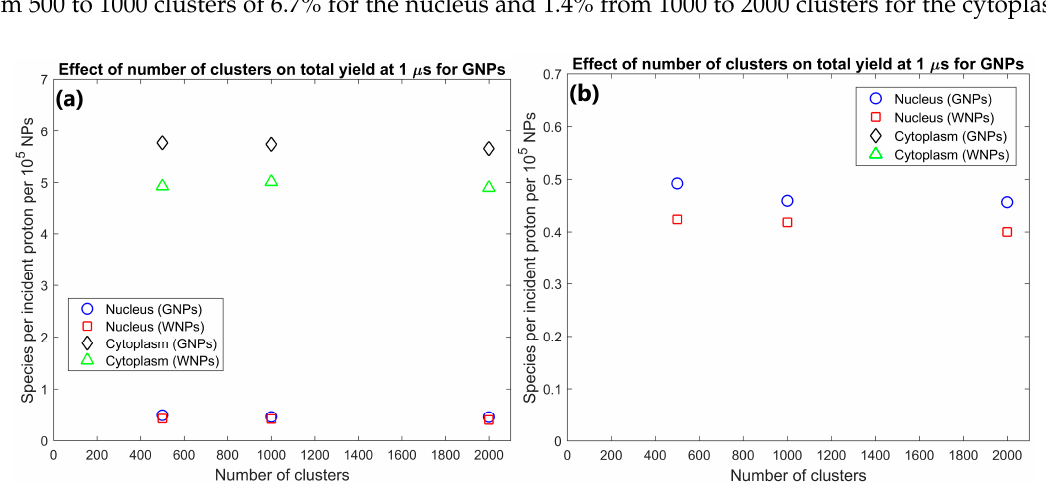
Figure 3. ( a ) Effect of number of gold nanoparticle (GNP) and water nanoparticle (WNP) clusters on reactive species yield at 1 µs from secondary electrons for cells with 500 − 2000 clusters of 200 nm diameter within the cytoplasm. Yield per 1000 clusters is shown. ( b ) Highlight of nucleus yields shown in (a).